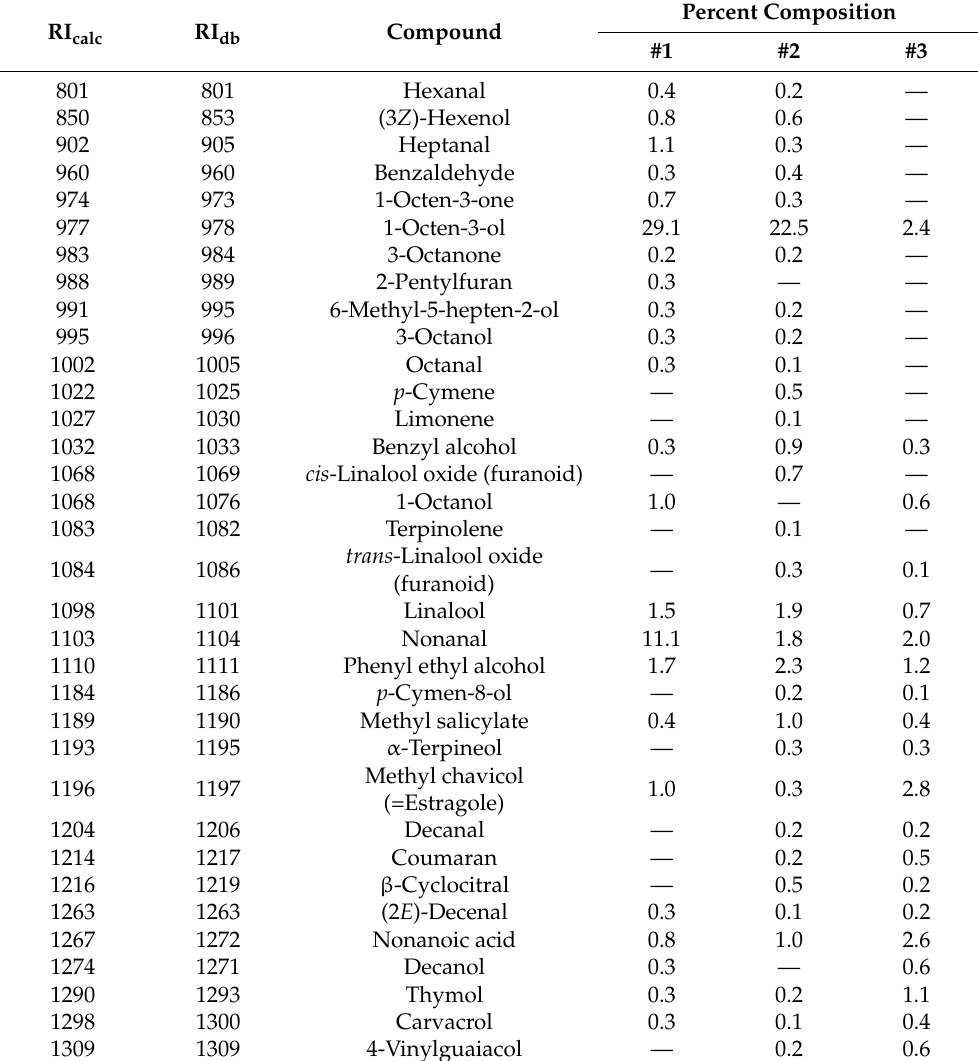
Table 8. Essential oil compositions of three samples of wild-growing Verbena hastata